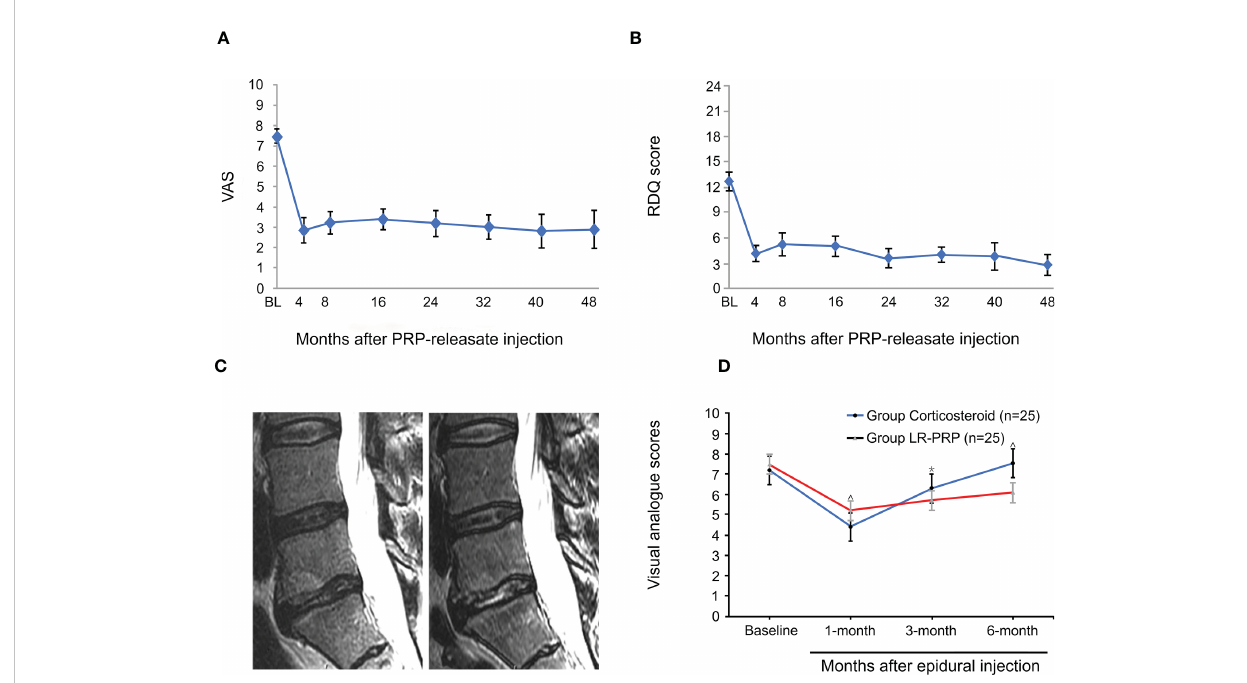
FIGURE 1 PRP for treatment of discogenic low back pain. Mean Visual Analogue Scale (VAS) score (A) and mean Roland-Morris Disability Questionnaire (RDQ) score (B) of patients after intradiscal injection of PRP. (C) Sagittal MRI one year before the caudal epidural and intraductal PRP injection showed increased T2 nuclear signal intensity and decreased type I Modic change in the L5-S1 disc compared to pre-injection. (D) Mean VAS scores were signi fi cantly lower at 3 and 6 months in patients who received LR-PRP injection. Reproduced with permission from (51 – 53). *P < 0.05 and ^P <